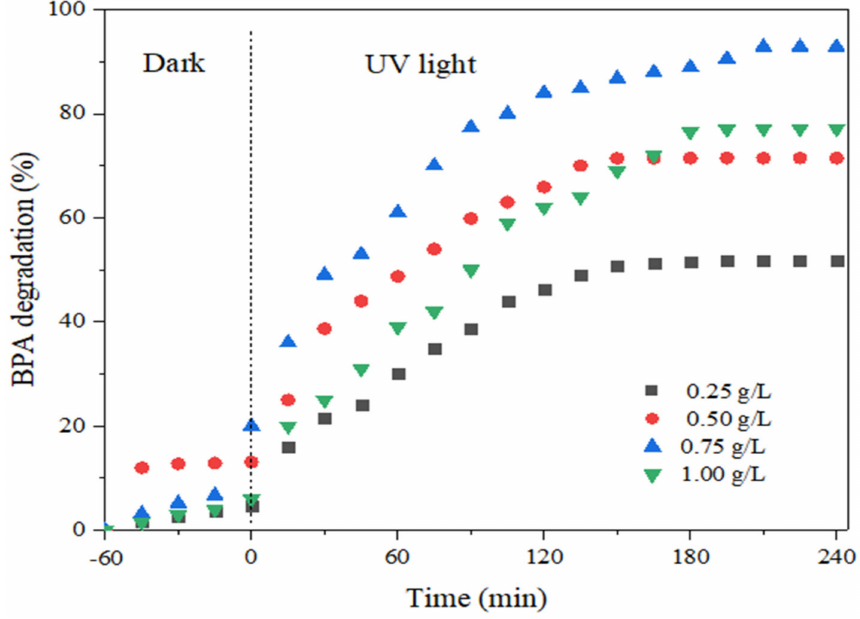
Figure 8. Degradation of BPA with different photocatalysts